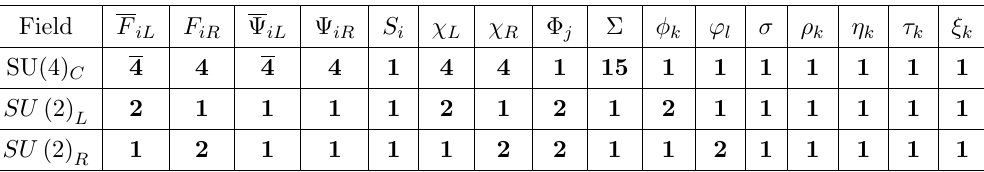
Table 1 . Particle content and transformation properties under the gauge